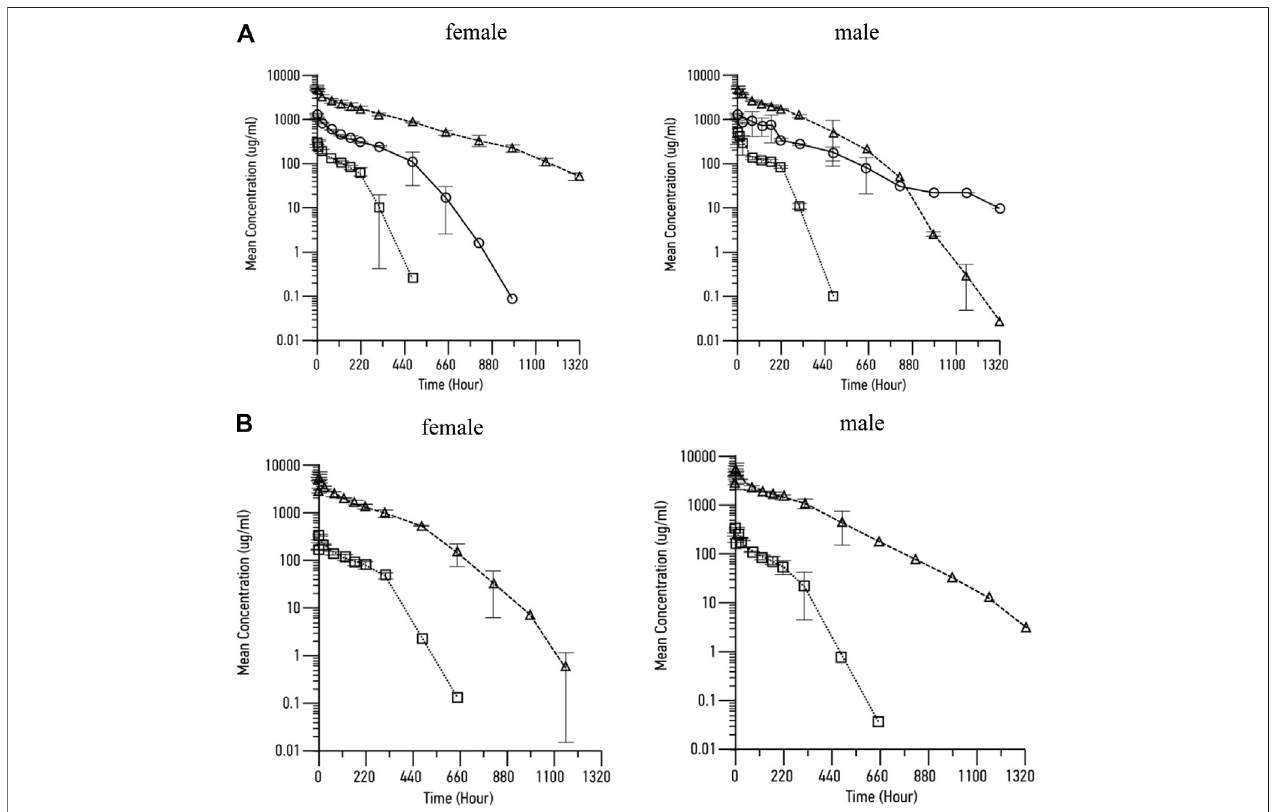
FIGURE 6 | Pharmacokinetic pro fi le of RPH-120 in male and female Cynomolgus monkeys. Panel A – mean RPH-120 concentrations in sera of female and male monkeysaftersingledosei.v.bolusinjectionofRPH-120(doses12.5;50and200 mg/kg);Panel B -meanRPH-120concentrationsinseraoffemaleandmalemonkeys after single dose i.v. infusion of RPH-120 (doses 12.5 and 200 mg/kg).